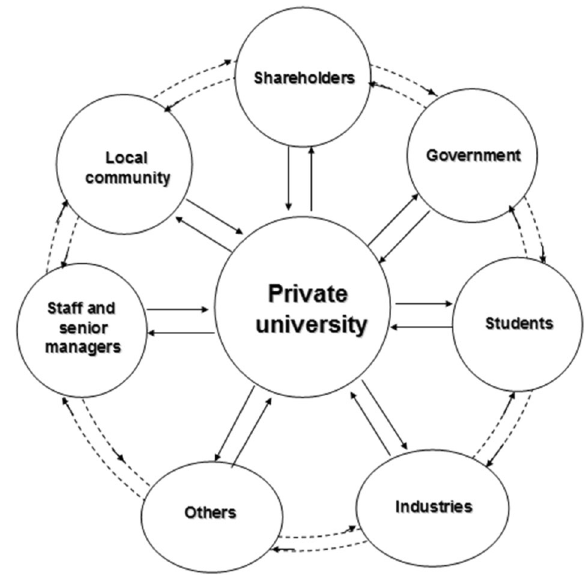
Fig. 2 Stakeholder theory in relation to private